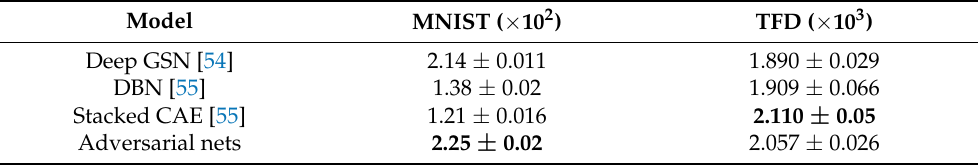
Table 2. Window-based mean log-likelihood estimation of adversarial networks versus deep belief networks, stacked conditional autoencoders and deep gradient stochastic